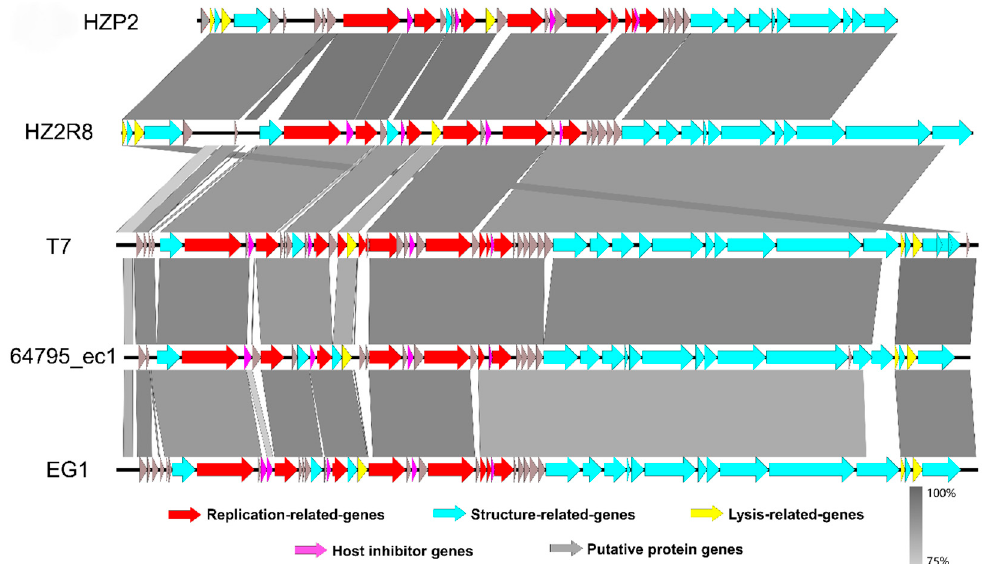
Figure 4. ORF-by-ORF comparison of the genomes of phage HZP2 and HZ2R8 and other homologous phages. The functional modules indicated by color. Similarities were showed in gray according to the scale on the left side.